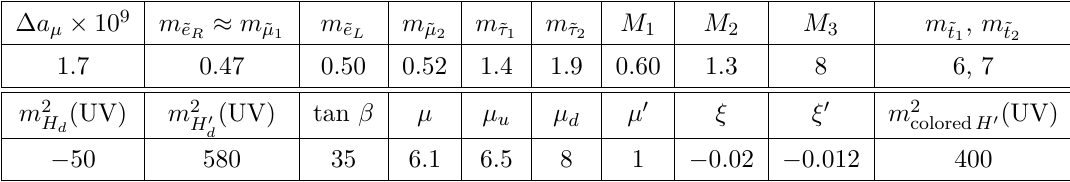
Table 3 . Benchmark model (BM5) with slepton LSP and R -parity violation. All quantities with mass dimensions are in units of TeV (2) . The standard EWSB is meta-stable, with lifetime larger than the age of the